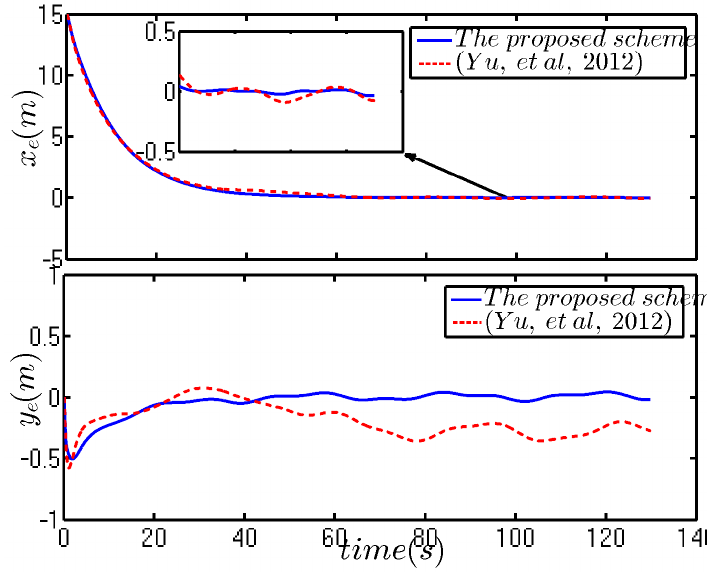
Figure 3. Comparison results of straight line trajectory tracking.